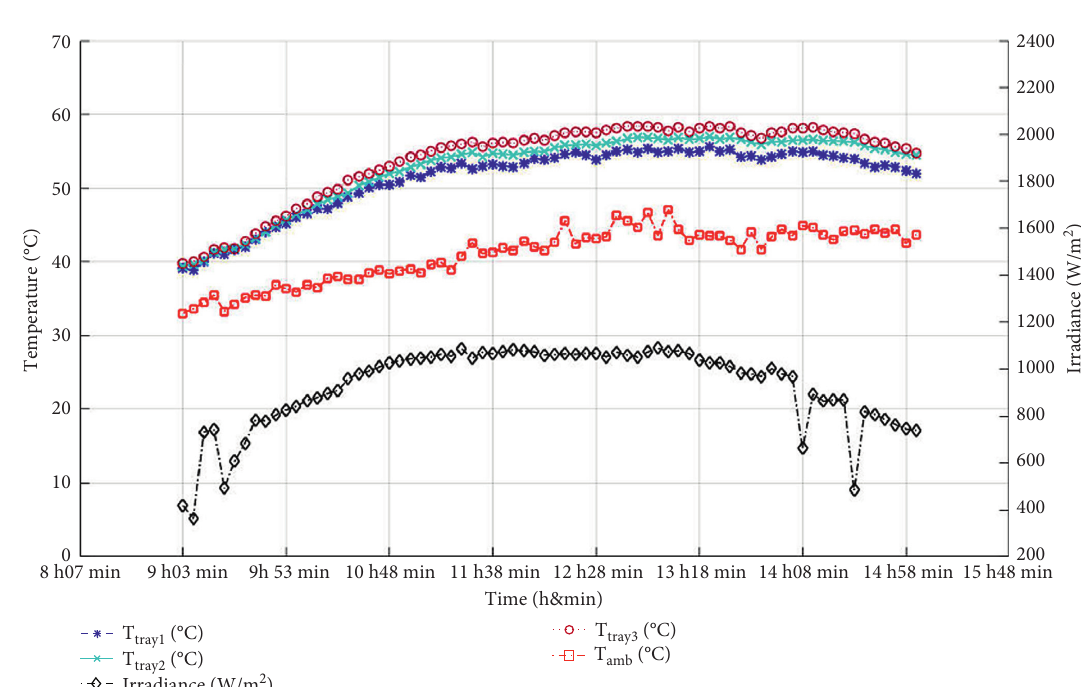
Figure 11: Temperature and irradiance profiles in mixed mode with